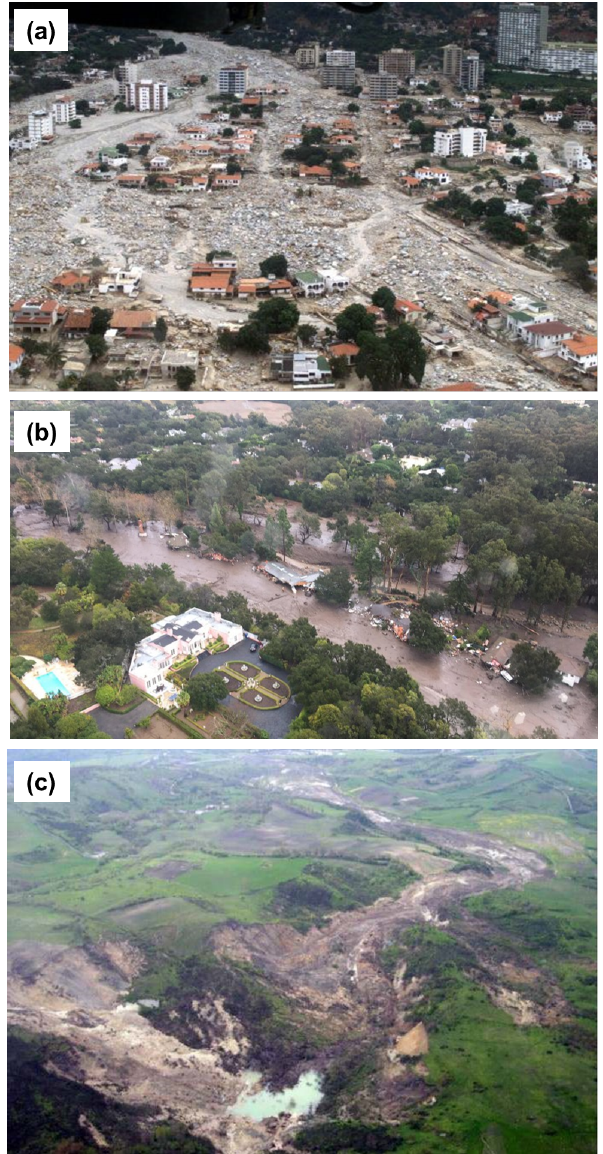
Figure 1. ( a ) Destruction caused by a debris flow in the Venezuelan town of Caraballeda (1999); courtesy of US Geological Survey. ( b ) Aerial shot of a post mudflow event at Montecito, USA (2018); courtesy of LA Times. ( c ) The Montaguto earth flow in Southern Italy (2006)